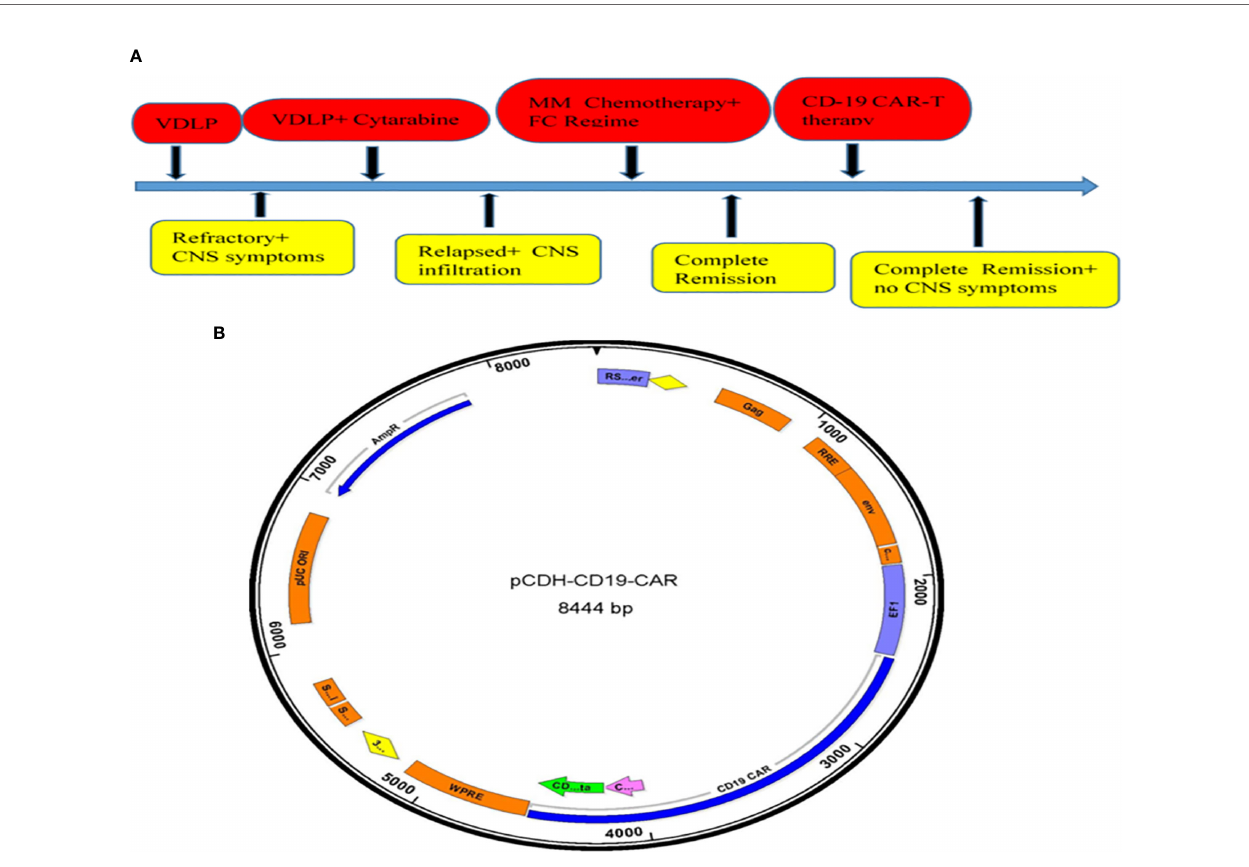
FIGURE 1 | Summary protocol of medication treatment and CD19CAR structure. (A) Summary protocol of the patient ’ s treatment. (B) The schematic diagram of